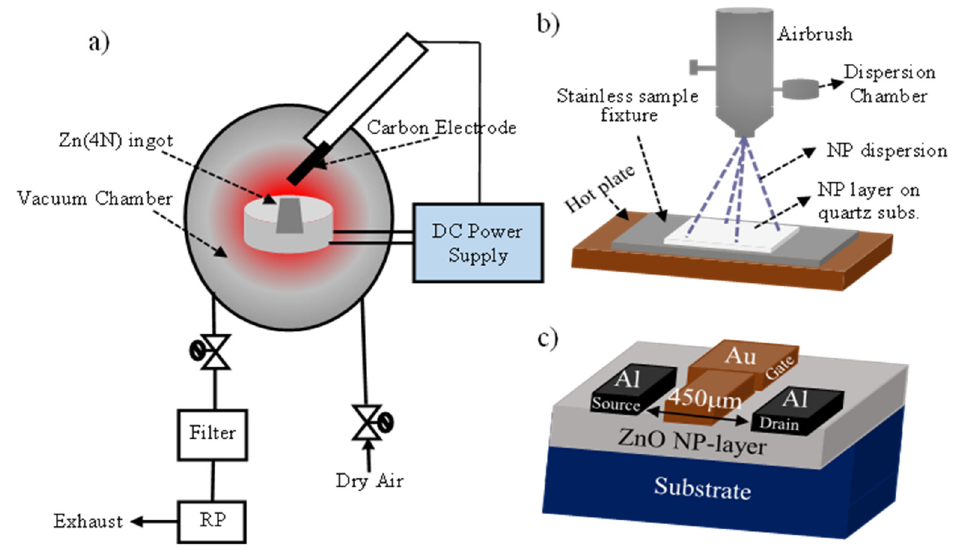
Figure 1. Schematics of the ( a ) arc-discharge-mediated, gas evaporation method for NP formation; ( b ) the spray-coating process; and ( c ) the MES-gate type thin-film-transistor structure.